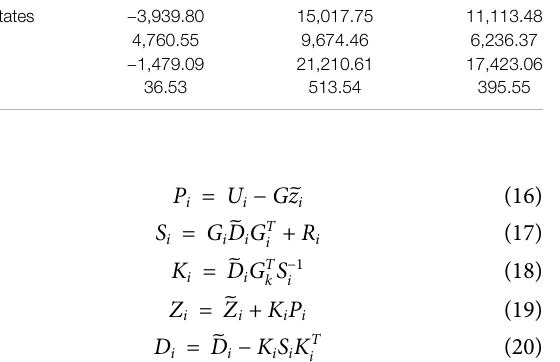
TABLE4| NumberofdailyrecoveredcasesoftheUnitedStates,India,Brazil,and Russia. Country Measurement tools